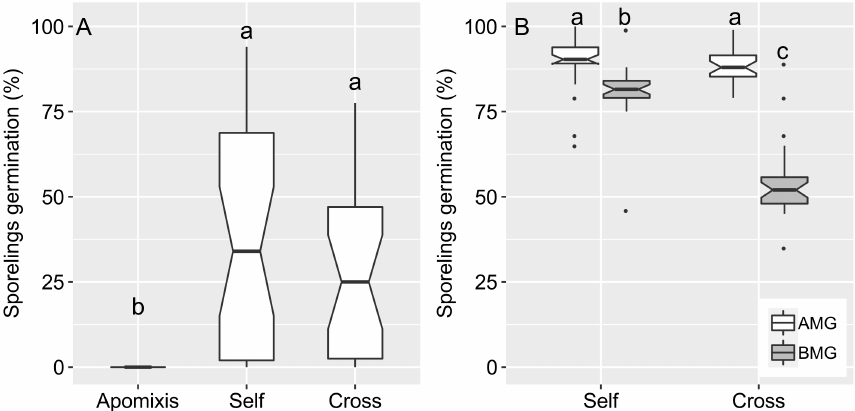
Figure 3. The two series of experiments to examine sexual reproduction in Isoëtes cangae and Isoëtes serracarajensis . ( A ) Percentage of spore germinations in apomixis (only megaspores, n = 730 megas- pores), crosses (n = 1480), and self-fertilization (n = 1310). Each point corresponds to one biological replicate with several megaspores (15–100), and the different symbols represent the four experiments of the first series. Detailed information in Table S1. ( B ) Percentage of I. cangae sporelings produced in the self-fertilization and cross-fertilization tests by adding microspores before megaspore germination (BMG) or after megaspore germination (AMG). Each point corresponds to one biological replicate with 10 megaspores (total of 300 megaspores per treatment). Boxes carrying the same letters indicate no significant differences between the treatments after a post-hoc Dunn’s test at p < 0.05.